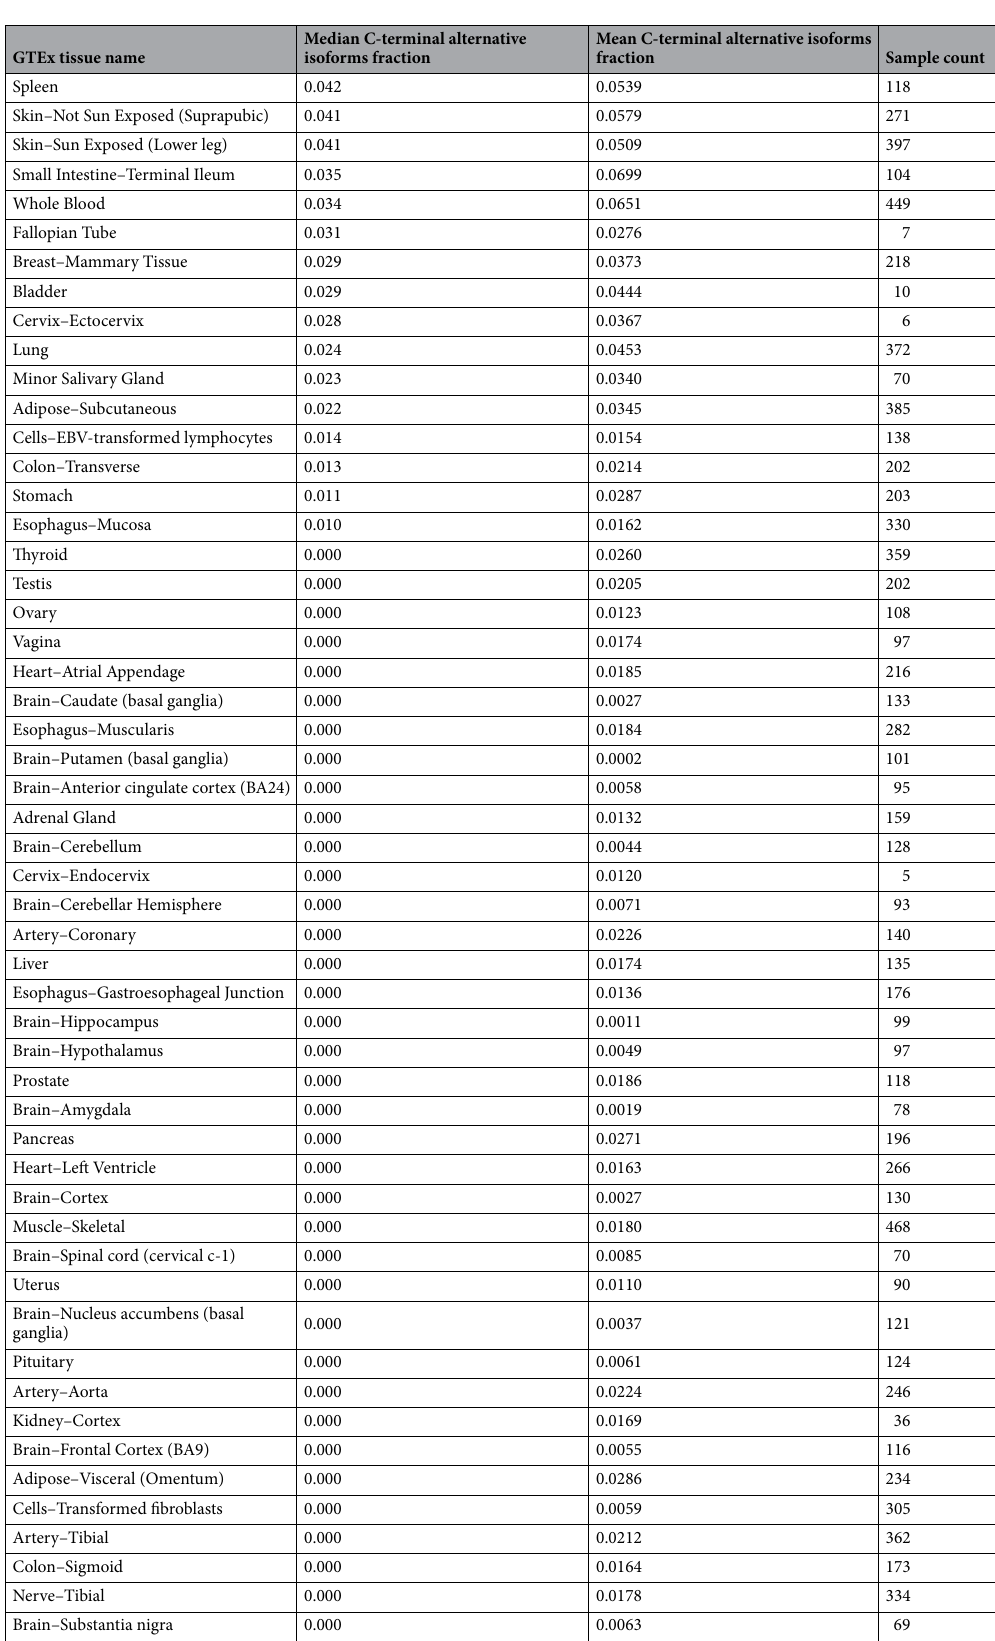
Table 1. Exonic fraction average and median percentage for C-terminal alternative isoforms across GTEx tissue